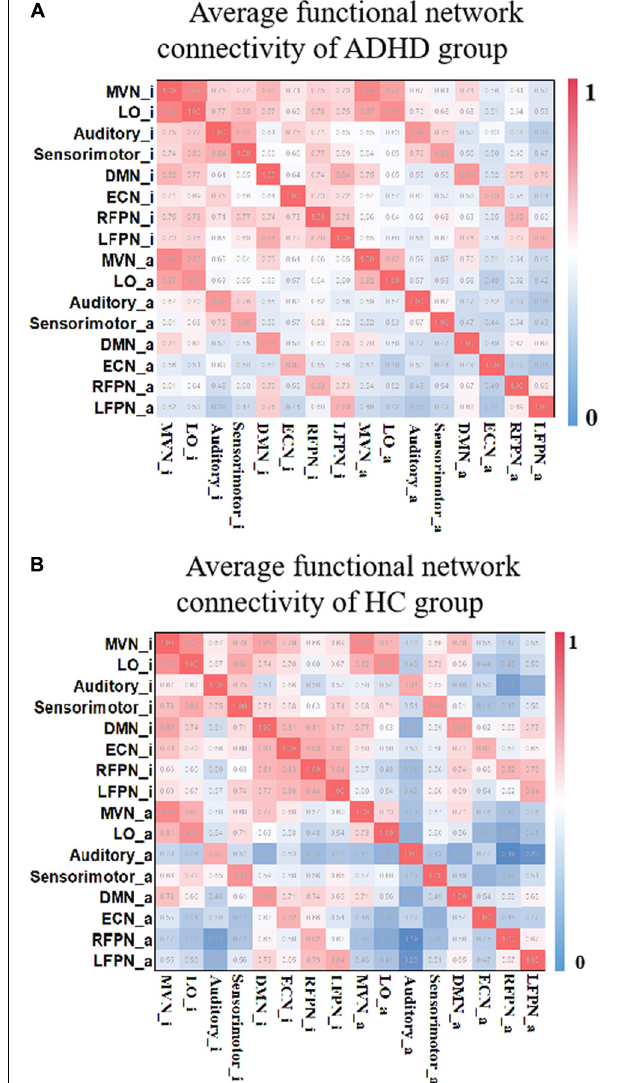
FIGURE 5 | The average functional connectivity of each group of subjects. (A) The FNCs of the HC group. (B) The FNCs of the ADHD group. “_i” represents the corresponding RIN, and “_a” indicates the corresponding AN. Both include the RIN and the AN, and µ = 3. FNC, functional network connectivity; HC, healthy control; ADHD, attention deficit hyperactivity disorder; RIN, relatively inert network; AN, activation network.